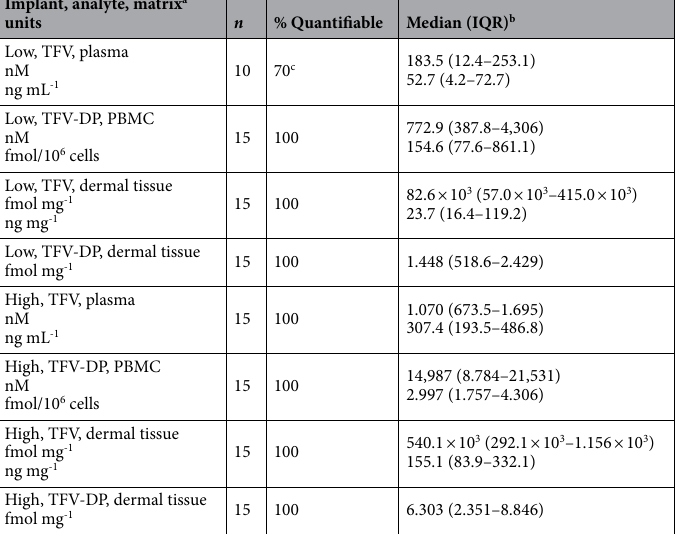
Table 1. Summary of equilibrium (Day 3–28) TFV and TFV-DP concentrations during implant use. Low, 0.28 mg d -1 TAF release in vivo; high, 0.58 mg d -1 TAF release in vivo. a All values correspond to time points (D3-28) with the implant in place. b Interquartile range, between first (25th percentile) and third (75th percentile) quartiles. c BLQ values were omitted from the